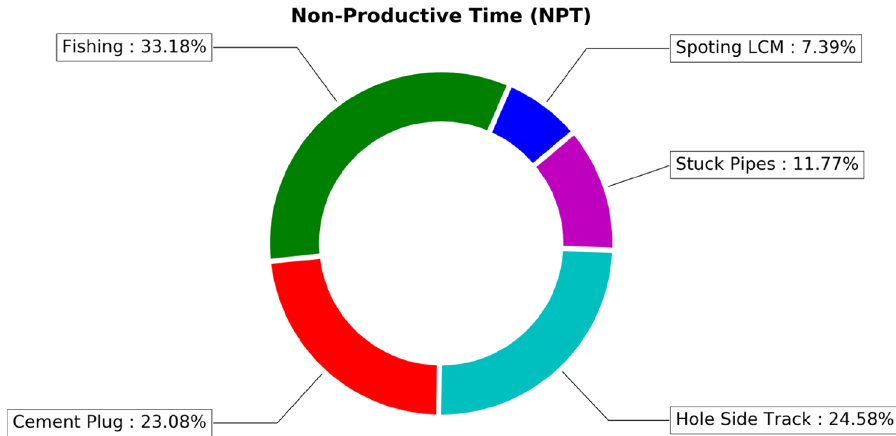
Fig. 2 Non-productive time (NPT), the consequences of lost circulation problems in the Azadegan